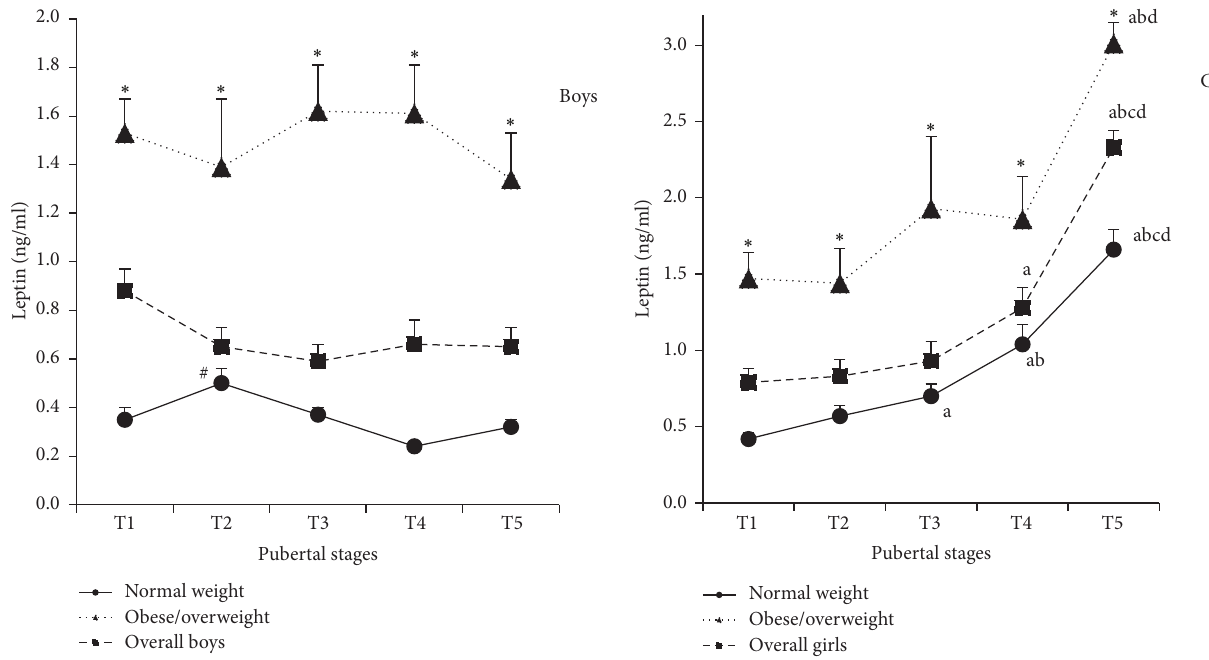
Figure 2: Serum leptin levels of boys and girls in different pubertal stages (boys: # compared with the other four stages, 𝑃 < 0.05 ; girls: a, b, c, and d compared with T1, T2, T3, and T4, resp., 𝑃 < 0.05 ; boys and girls: ∗ compared with normal weight children in each pubertal stage, 𝑃 < 0.05